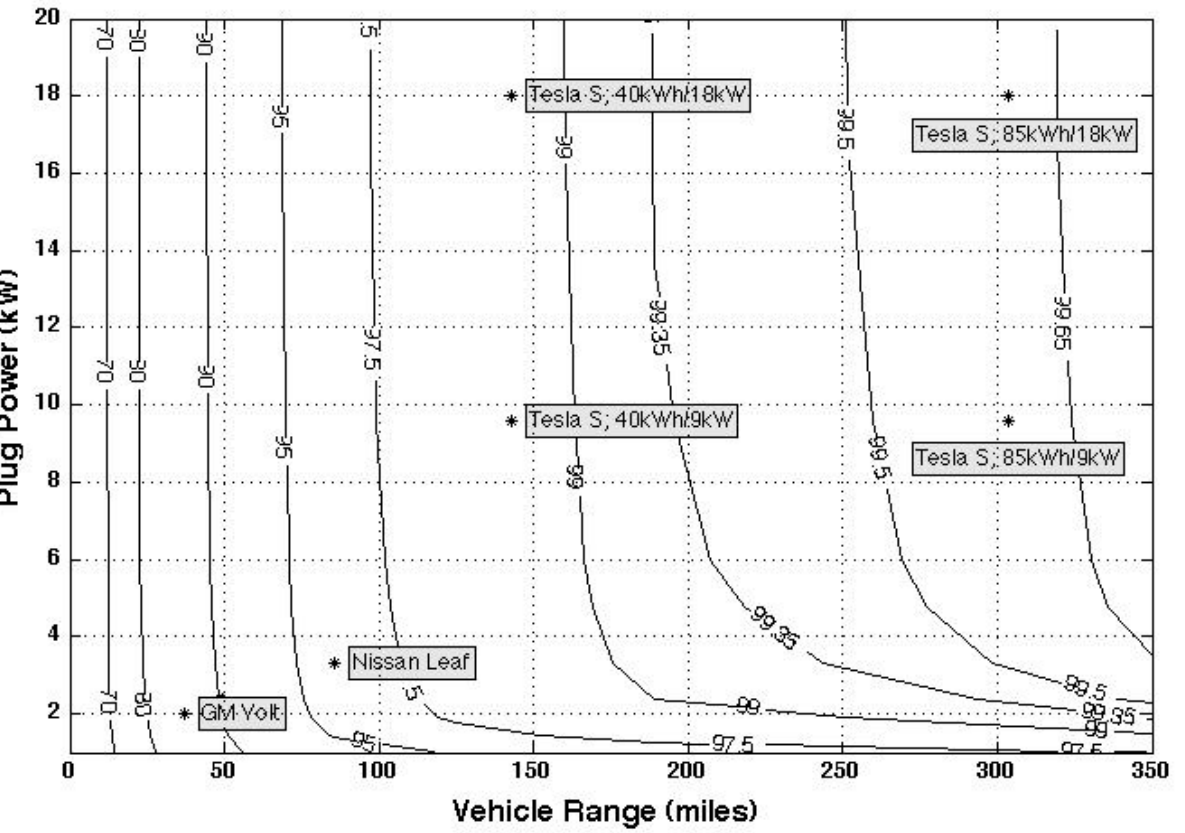
Figure 3. Success fraction (in percent of round trips) for charging at Home only. Success is a percentage of all cars and all trips over the year’s trip inventory. Reprinted by permission, from Pierre [24].